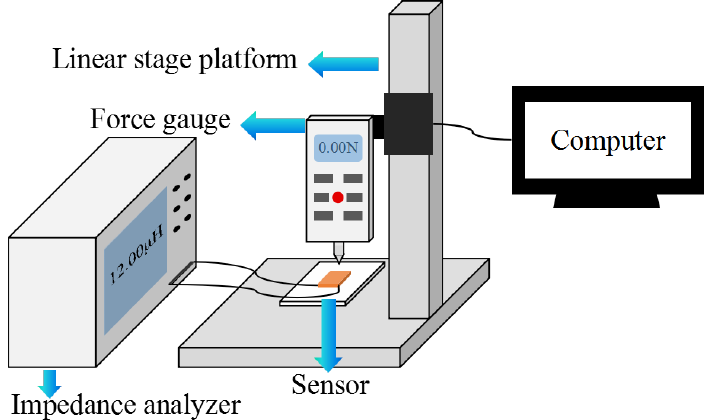
Figure 2. The measurement setup for the device calibrations.